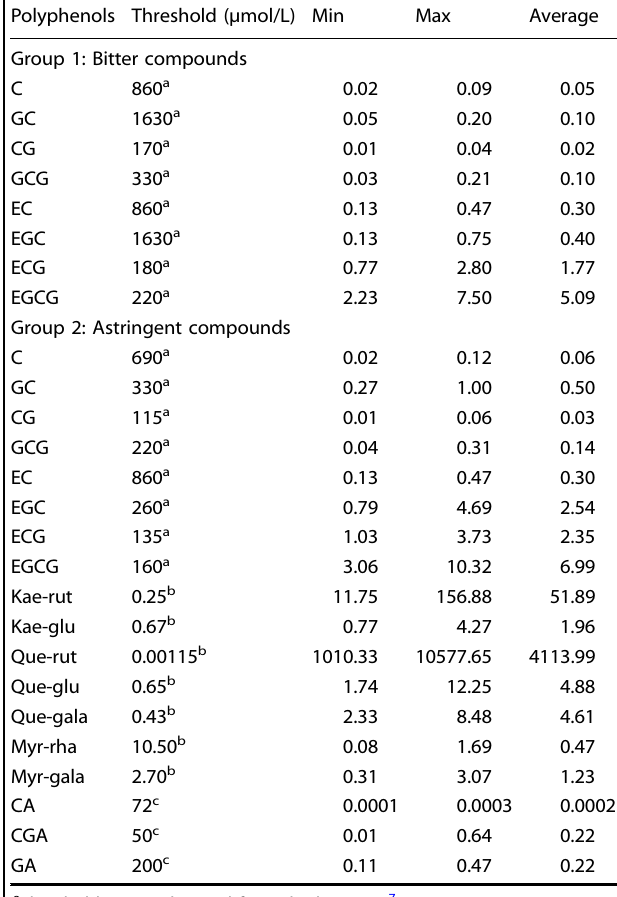
Table 2. Dot analysis of the polyphenols in green tea